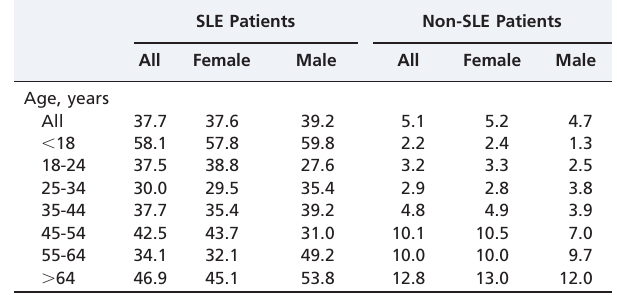
Table 3 - Average daily prednisolone (Pd) equivalent dose and Charlson co-morbidity index (CCI) for the SLE patients and non-SLE controls, as stratified by age.